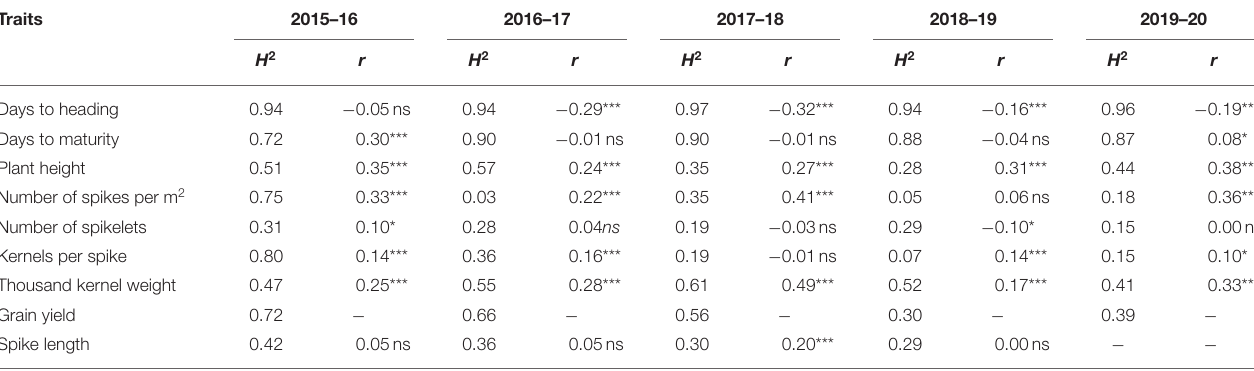
TABLE 1 | Broad-sense heritability of agronomic traits and correlation between agronomic traits and grain yield (GRYLD) for five growing seasons from 2015–16 to 2019–20 for wheat grown in Bangladesh.